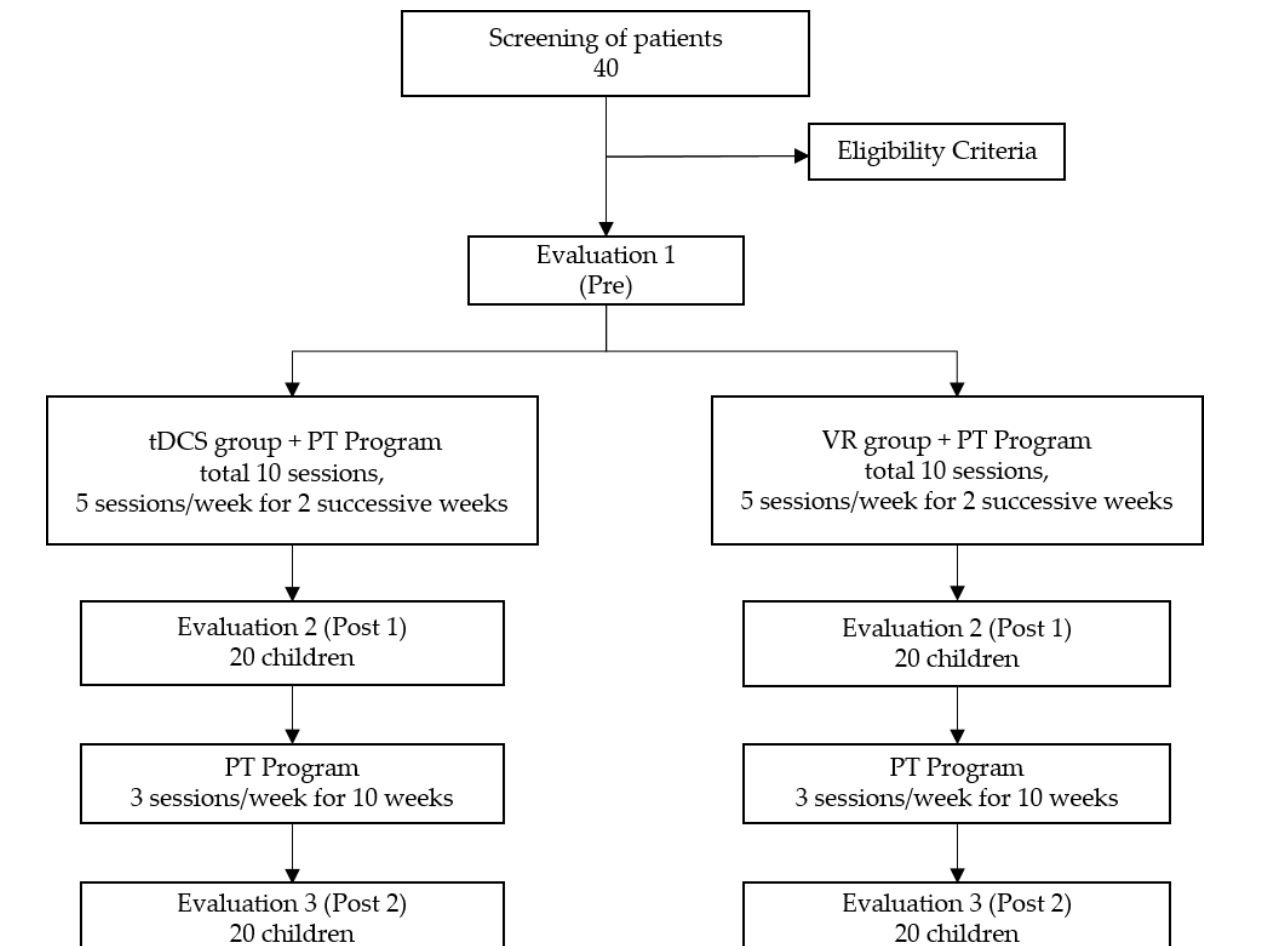
Figure 1. Flowchart of study based on consolidated standards of reporting trials (CONSORT).